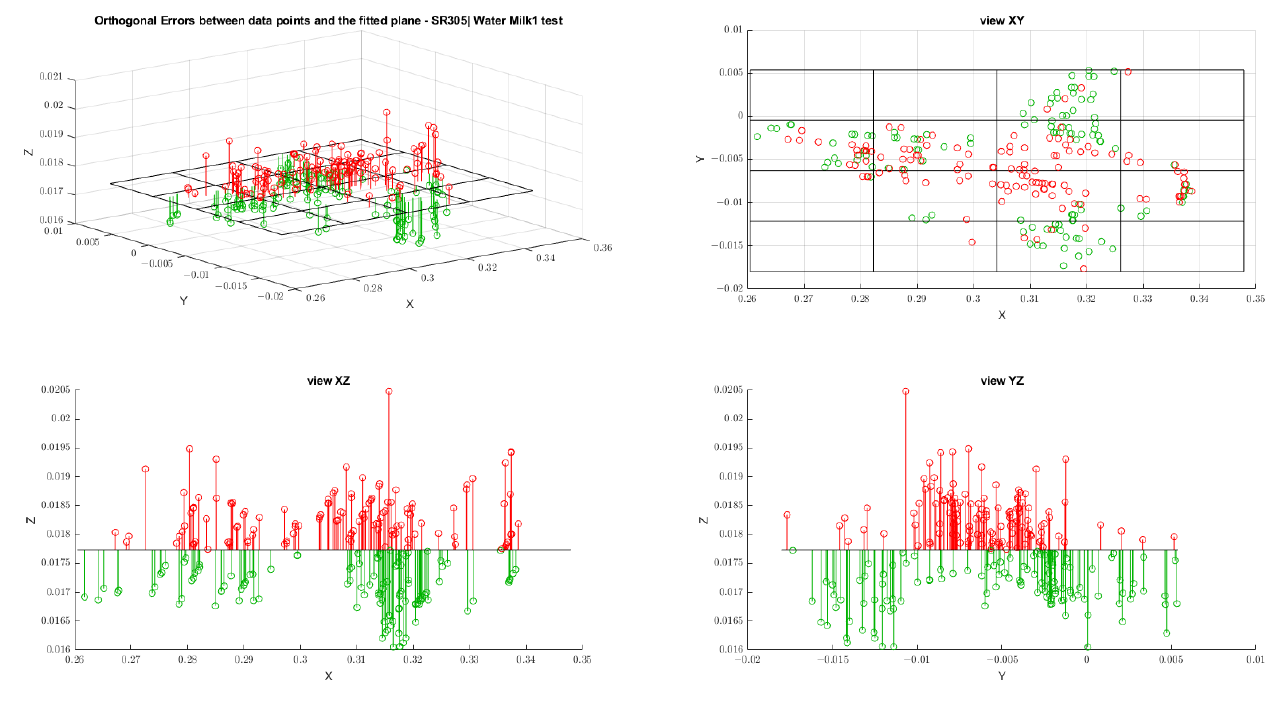
Figure A18. Results of orthogonal errors for the SR305 camera referring to the water milk1